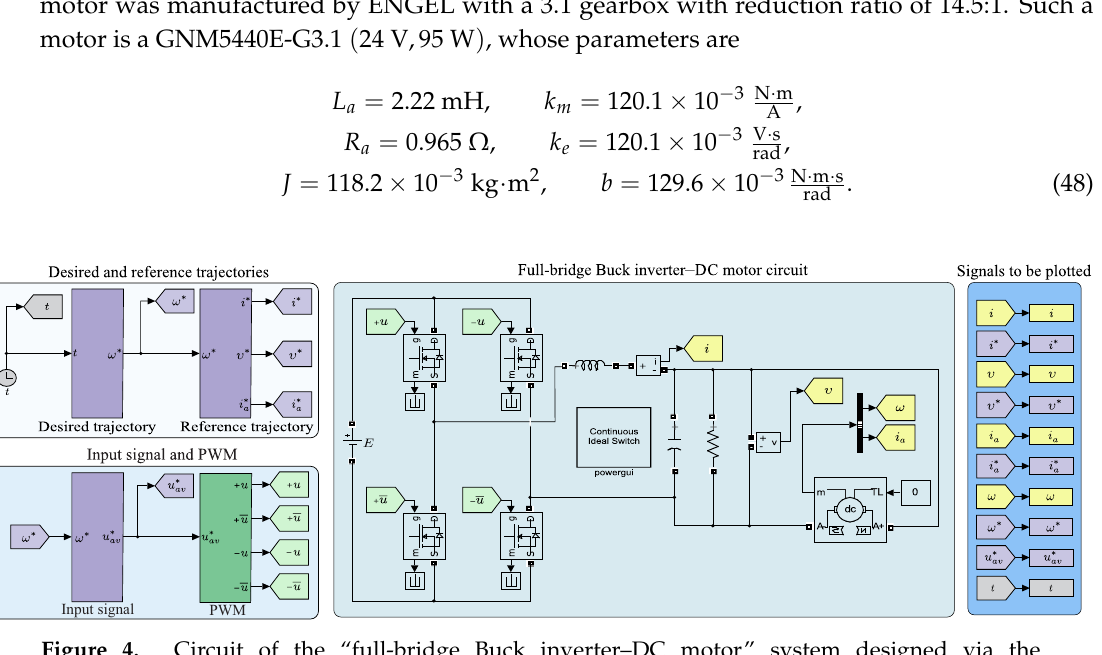
Circuit of the “full-bridge Buck inverter–DC motor” system designed via the SimPowerSystems toolbox of Matlab-Simulink. This circuit is used for validating the deduced mathematical model of such a